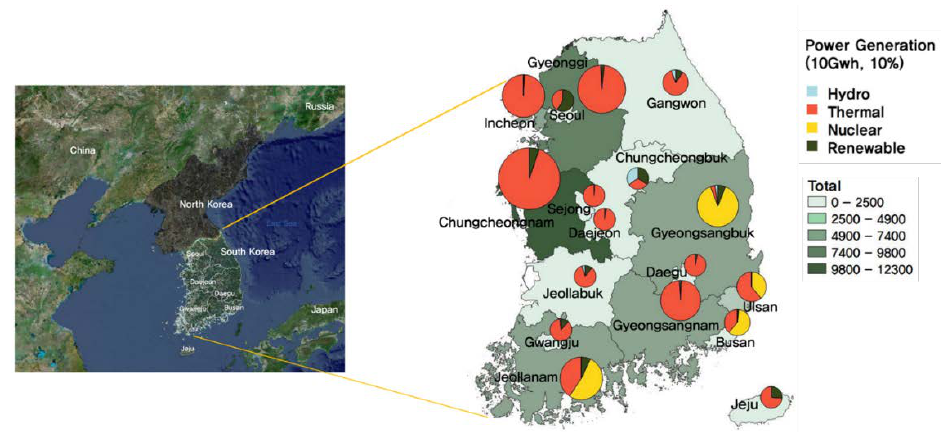
Figure 2. Annual power generation by regions and sources in Korea (note: circle size indicates the relative total amount of power generation when the value of CN is equivalent to 1).